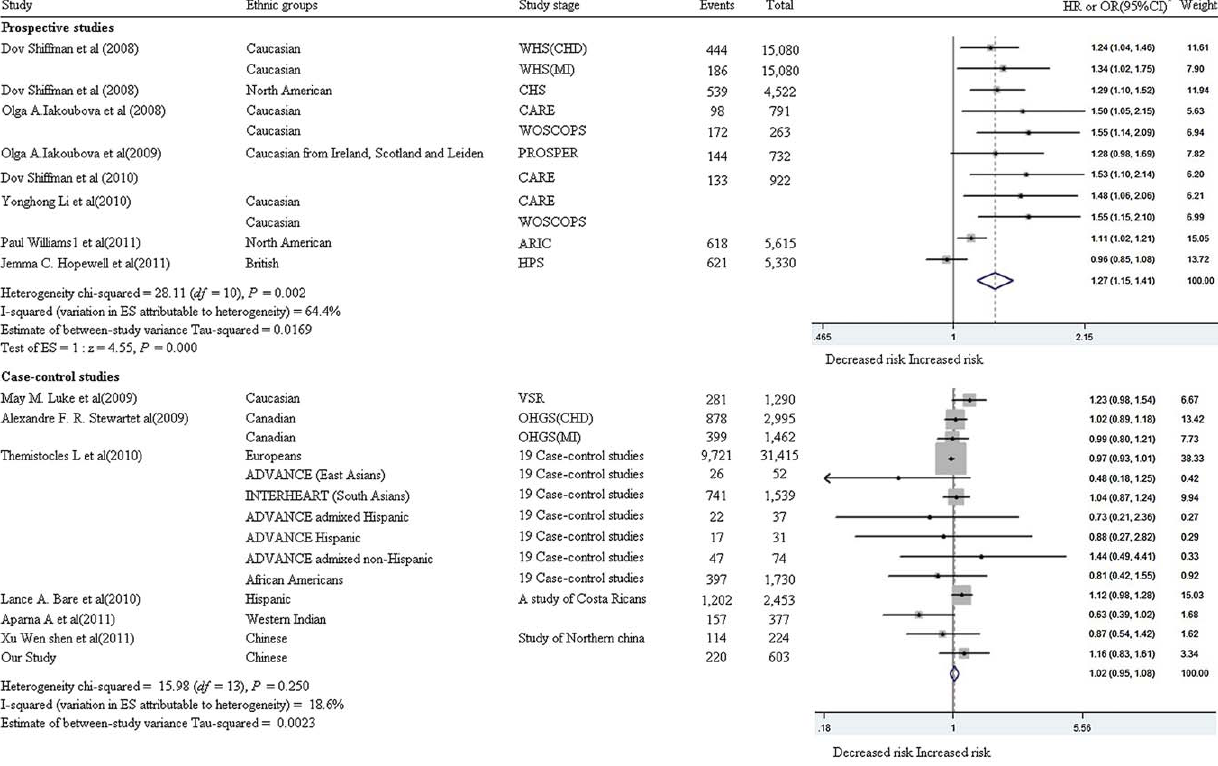
Figure 1. Meta-analyses between Trp719Arg and CHD. a: CARE (the Cholesterol and Recurrent Events study); WOSCOPS (the West of Scotland Coronary Prevention Study); PROSPER (PROspective Study of Pravastatin in the Elderly at Risk); HPS (the Heart Protection Study); ARIC (the Atherosclerosis Risk in Communities study); CHS (the Cardiovascular Health Study); WHS (the Woman’s Health Study); OHGS (Ottawa Heart Genomics Study); VSR (Vienna Stroke Registry); *: Reference allele is